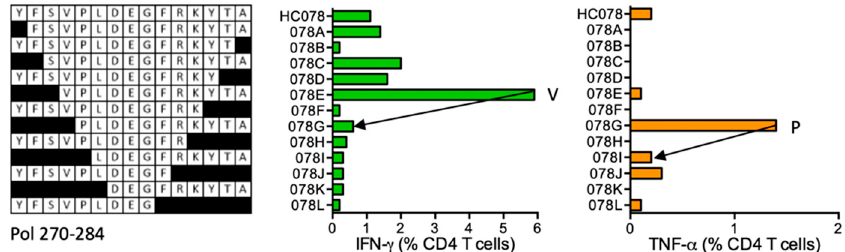
Figure 4. HC078 / VID 417—definition of CD4 + T-cell epitopes in HIV-1 protein Pol. PBMC of subject 417 were expanded by HC078 and stimulated with truncated peptides (left) in ICS. IFN- γ (green) and TNF- α (orange) producing CD4 + T cells were determined. Arrows in the graphs and amino acids V and P indicate the stimulatory peptide termini.